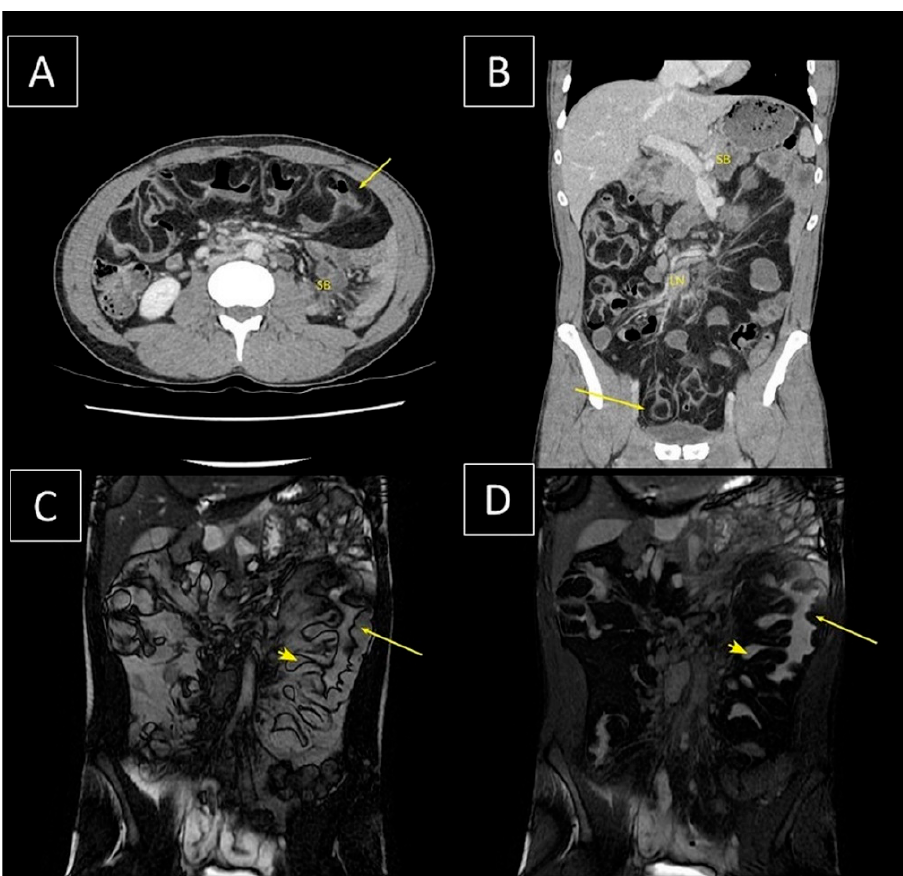
Figure 1. ( A ) Preoperative Axial CT with portal venous phase intravenous contrast and oral contrast demonstrating thickening of the ileal loops (arrow) and small bowel loops with no mural thickening (SB). The thickened ileal loops demonstrate similar attenuation values as the adjacent mesenteric fat, suggestive of infiltration by fat. ( B ) Coronal images from the same CT demonstrating submucosal fatty infiltration of ileal loops (arrow), small bowel loops with no mural thickening (SB), and mesenteric lymphadenopathy (LN). ( C , D ) Corresponding coronal images from the FIESTA sequences (balanced steady-state gradient echo sequence) of the MR enterography. Loss of signal in the small bowel mural thickening (arrows) on the fat-suppressed FIESTA image ( D ) suggests that the infiltrative material is macroscopic fat. The arrowhead demonstrates one of the numerous diverticula in the involved small bowel.